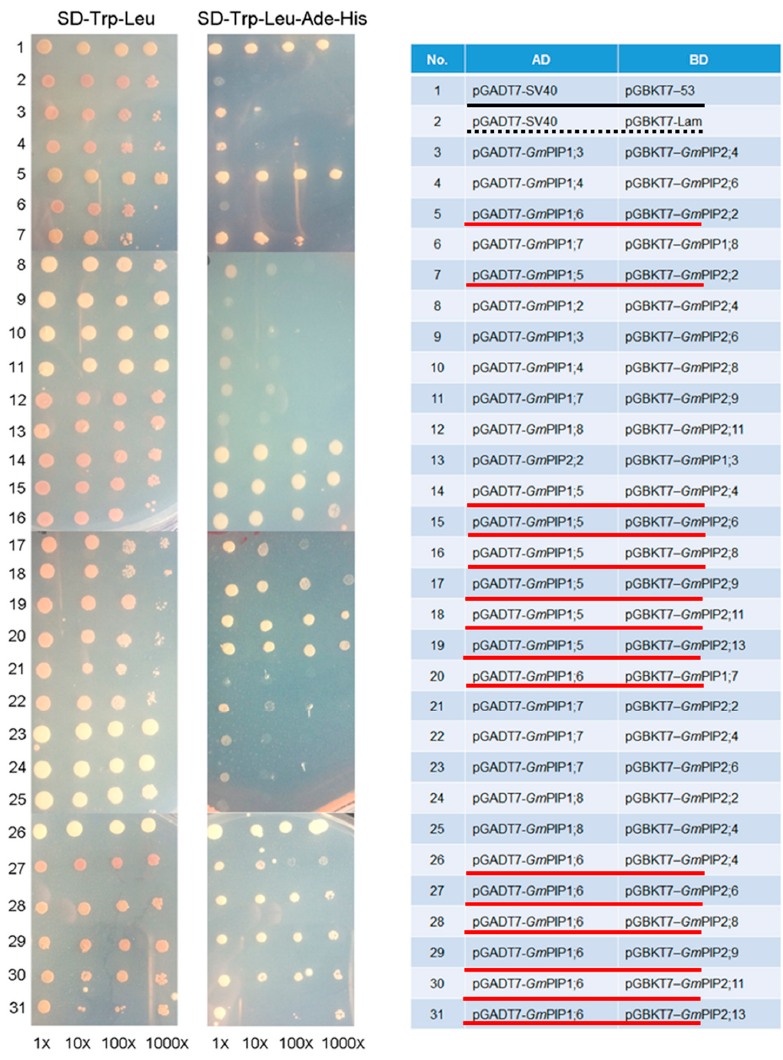
Figure 2. The yeast two-hybrid (Y2H) assays show that Gm PIP1s and Gm PIP2s interact to form heterotetramers. Full-length GmPIP genes were cloned into pGADT7 (with the activation domain, AD) and pGBKT7 (with the DNA-binding domain, BD). Different combinations of pGADT7 and pGBKT7 constructs were co-transformed into the Y187 and Y2H gold yeast strains. Yeast cells were grown in liquid selective media to OD 600 = 1.0, and then spotted at 1-, 10-, 100-, and 1000-fold dilutions on the SD-Leu-Trp and SD-Leu-Trp-Ade-His selective plates. All the plates were incubated at 30 °C for colony growth. Yeast cells harboring pGBKT7–53/pGADT7-SV40 plasmids were the positive control, and those with pGBKT7-Lam/pGADT7-SV40 were the negative control. The numbers 1–31 represent the AD and BK vectors listed in the table on the right. The GmPIPs were selected according to the results of phylogenetic and gene expression analyses depicted above. Those without significant changes in their gene Els were not picked up. The phylogenetic analysis indicated that Gm PIP1;1 and 1;2, 1;4 and 1;5, and 1–6 and 1;7, and GmPIP2;1 and 2;2, 2;3 and 2;4, 2;6 and 2;6, 2;7 and 2;8, 2;10 and 2;11, and 2;13 and 2;14 had high similarity. In each pair, one GmPIP was selected for the Y2H assay. However, GmPIP1–4 and GmPIP1–5 were selected because in the qPCR assay, they showed opposite expression patterns in response to salt stress. Moreover, GmPIP1;6 and GmPIP1;7 were also chosen because previous research reported GmPIP1;6 was relevant to salt and drought tolerance [20]. Samples No.1, 2 were positive and negative controls, which are underlined by the solid and dotted lines in black, respectively. The combinations that showed strong interaction are underlined in